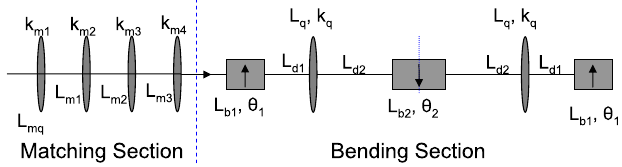
FIG. 5. (Color) Beam optical functions for the first order achro- matic bend.